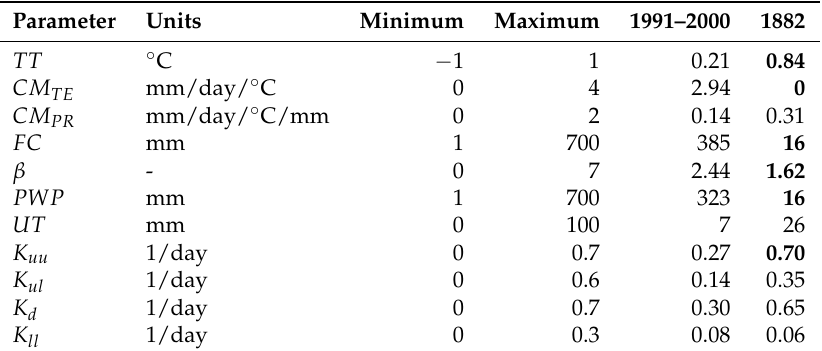
Table 1. HBV model parameter values for present and historical calibrations using DE. Parameter values of suspicious magnitude are in bold